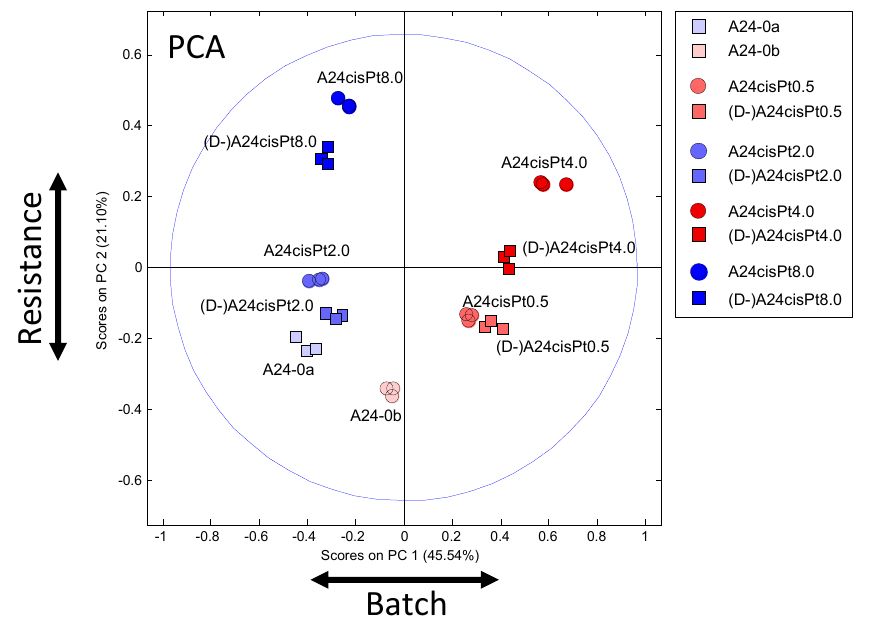
Figure 3. PCA scores plot (PC-1–PC-2) of all samples using the color and form coding introduced in Figure 1.